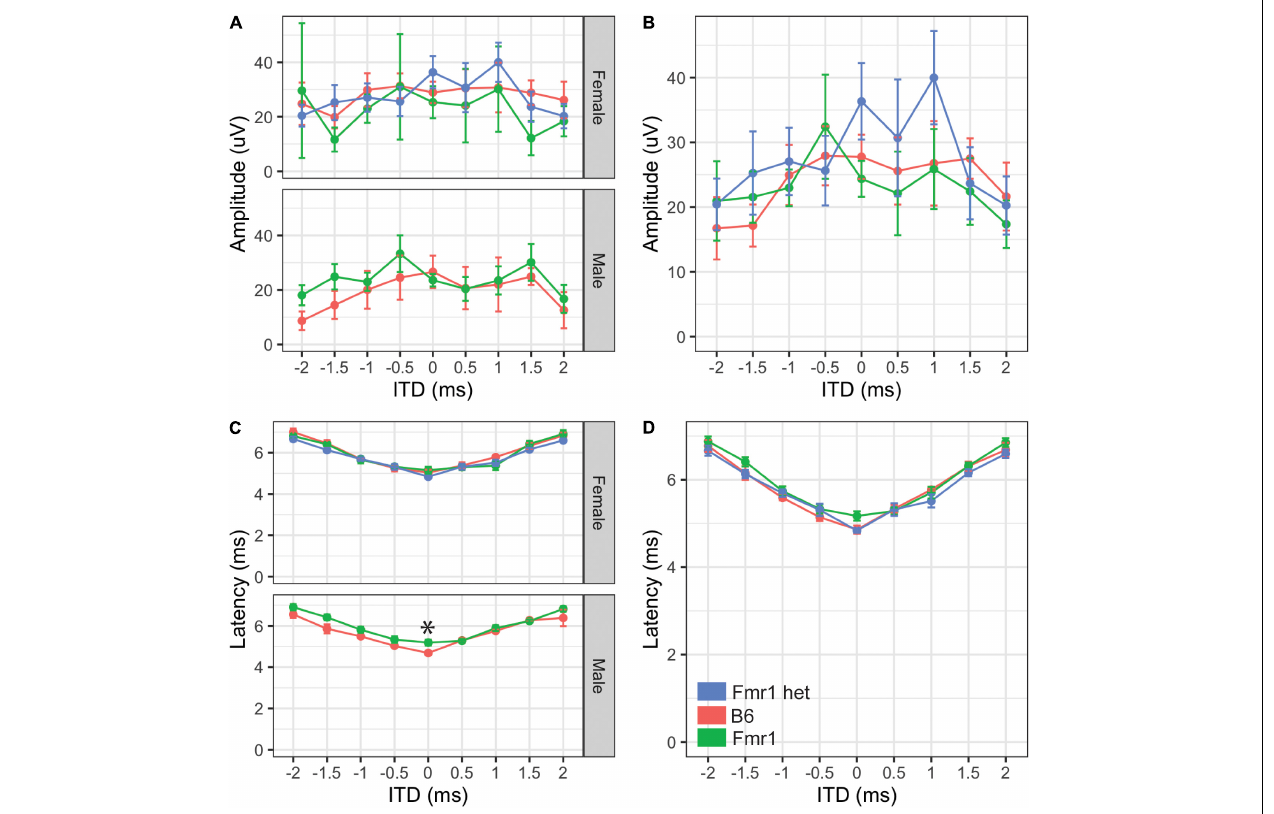
FIGURE 5 | Binaural hearing in Fragile X syndrome (FXS) mice. Binaural amplitudes and latencies for the BIC at ITDs between –2 to + 2 ms in 0.5 ms steps were recorded for Fmr1 (green), Fmr1 het (blue), and B6 (red) animals. No differences in amplitude of the BIC with ITD for females ( A , upper) or males ( A , lower). When the sexes were combined, there was no significant difference in amplitude of the BIC with ITD (B) . Fmr1 males had significantly longer latency of the BIC at 0 ITD compared with B6 males (C, lower), while there was no difference in latency of female responses ( C , upper). When the sexes were combined, there was no difference in the BIC latency across ITDs between the genotypes (D) . * p < 0.05. Data represent 6 B6, 7 Fmr1, and 9 Fmr1 het females and 6 B6 and 9 Fmr1